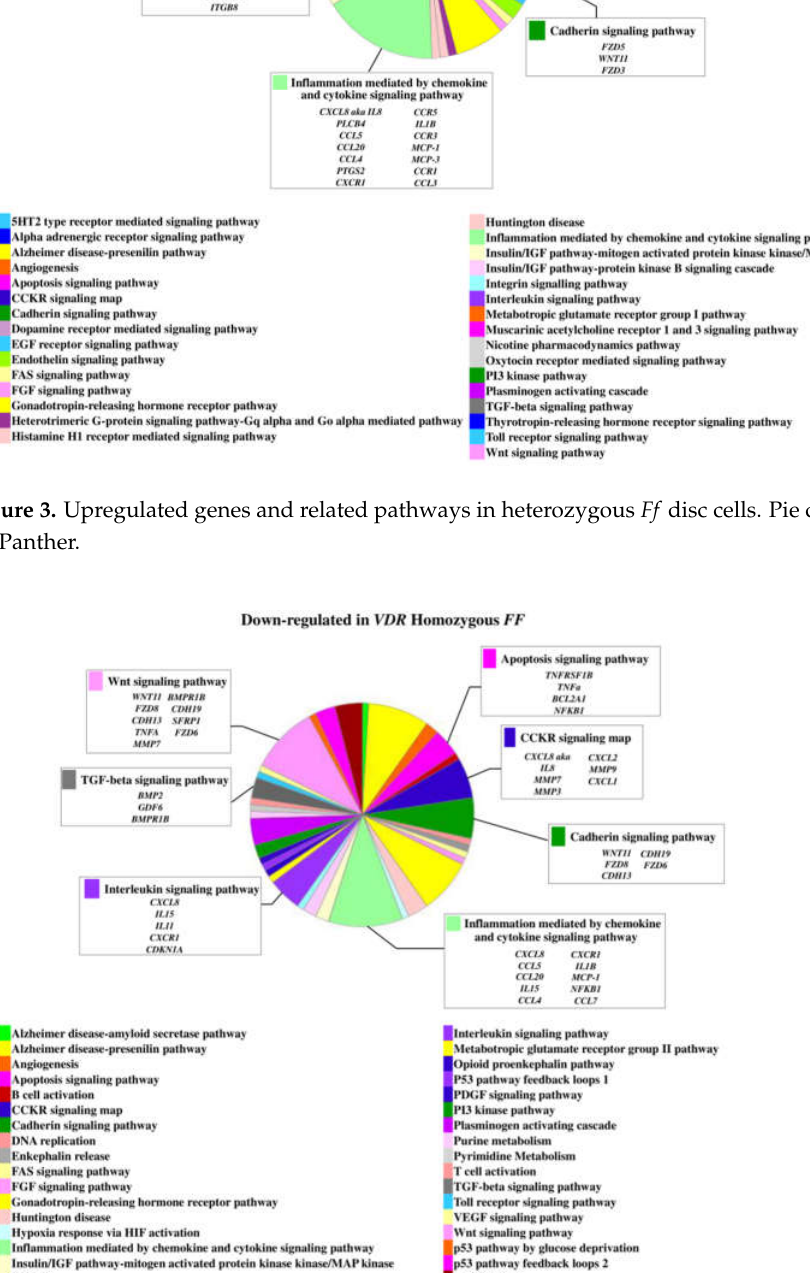
Figure 4. Downregulated genes and related pathways in homozygous FF disc cells. Pie chart obtained by Panther.